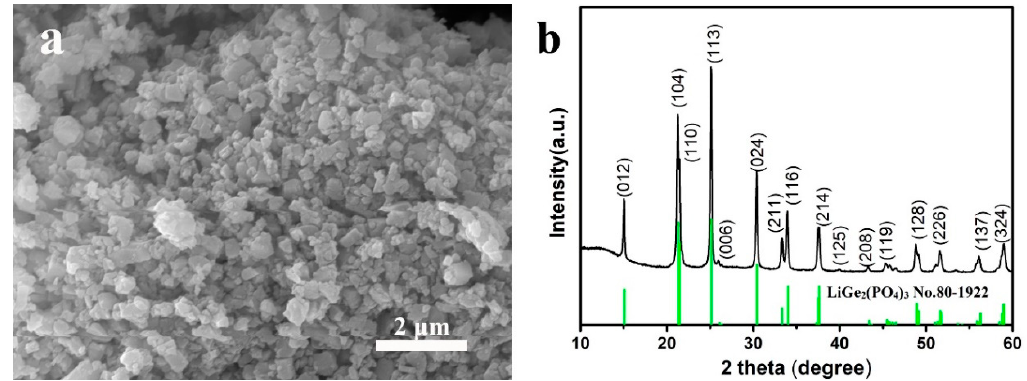
Figure 1. ( a ) SEM image and ( b ) XRD pattern of lithium aluminum germanium phosphate (LAGP) powders.